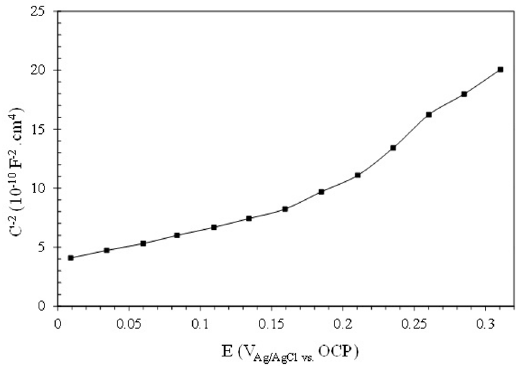
Figure 9. Mott-Schottky plot of the AISI 409 stainless steel after immersion for 24 h in 0.1 M NaCl solution at room temperature.